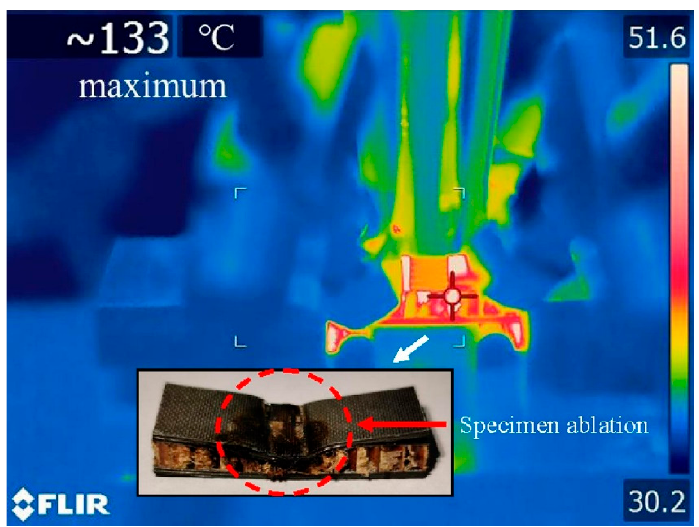
Figure 6. An exemplary thermal fatigue failure induced by self-heating effect in CFRP-aramid honeycomb sandwich structure under three-point cyclic bending in ultrasonic HCF regime, adapted with permission from Ref. [44]. Copyright © 2022 Elsevier